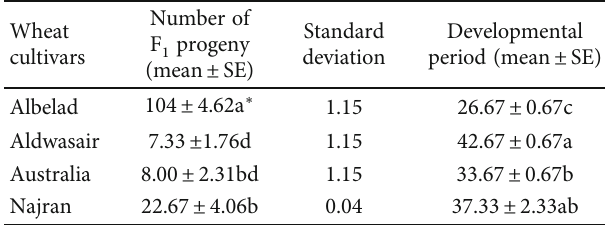
Table 1: Mean weights of wheat varieties/1000 grains. Mean of weight ± S.E.